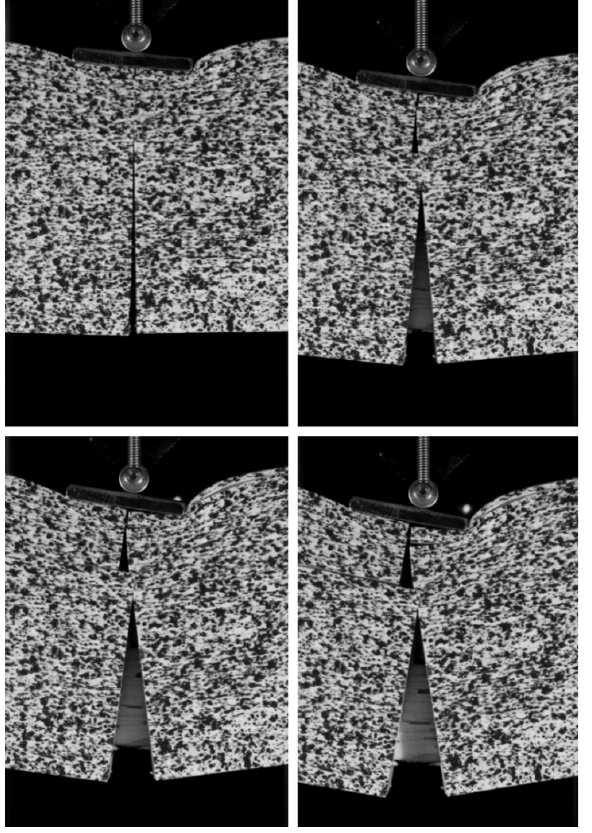
Figure 10. Damage evolution of the beam #08 with the failure F2 - splinter around the ligament and shear failure.